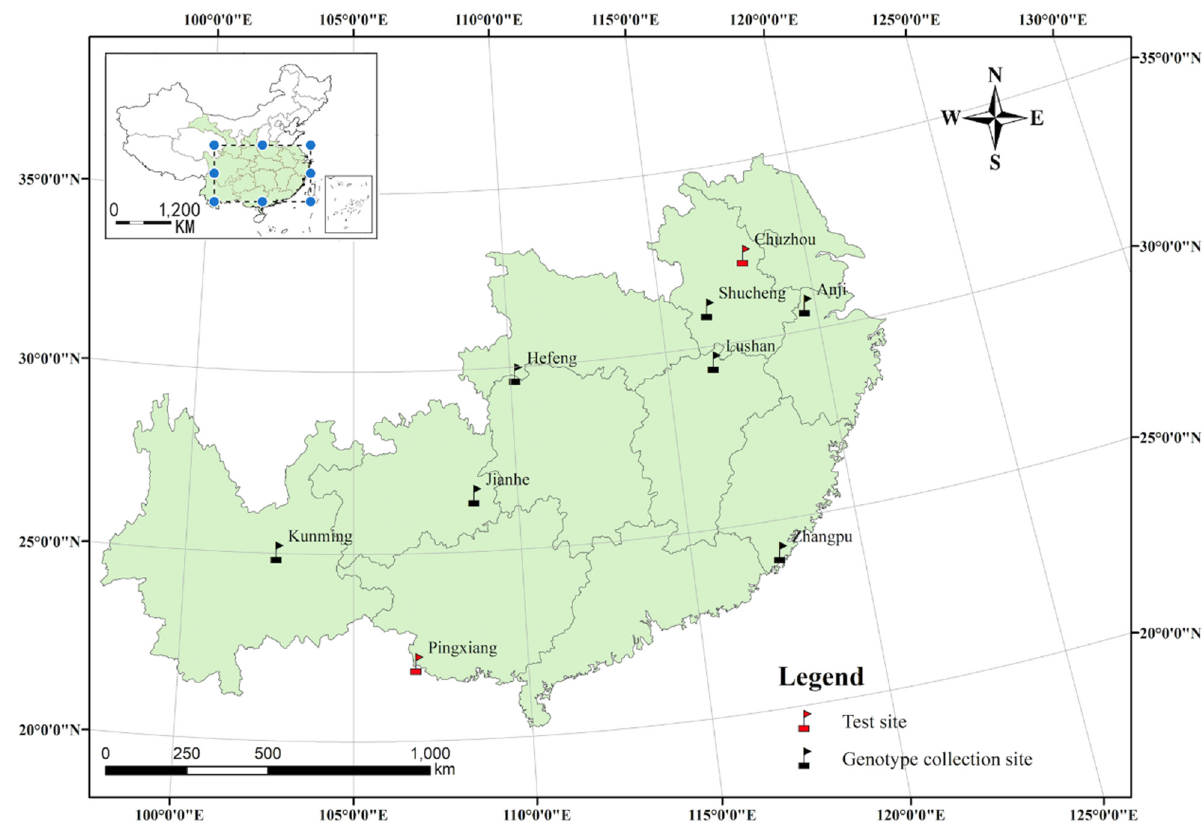
Figure 1. A map of the natural distribution (a small map with a dotted blue line box), genotype origin, and test sites for Cyclocarya paliurus (Batal.) Iljinskaja.